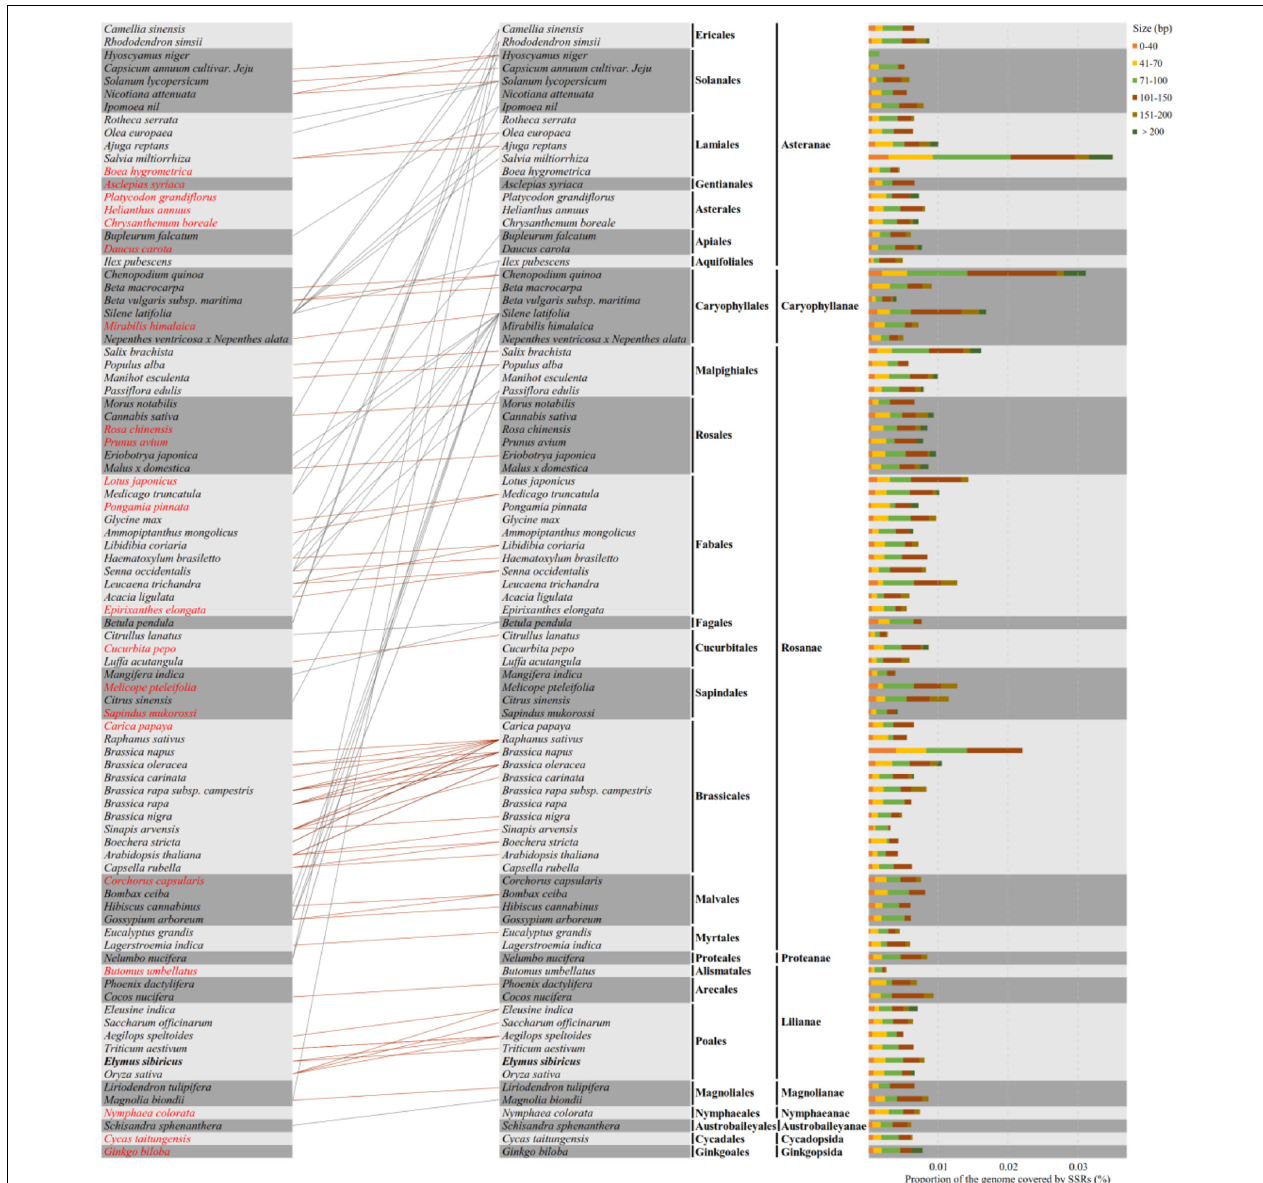
FIGURE 7 | Compound mitogenome simple sequence repeat (SSR) sequences (mt-c-SSRs) identified in 88 mitogenomes of seed plants. The types and proportions of mt-c-SSRs are shown on the right, and the cluster analysis indicating the relationships and mt-c-SSRs transfer among all species is presented on the left. The orange and gray lines show relationships within and between taxa, respectively. Species that have no connection with any other ones are colored in red